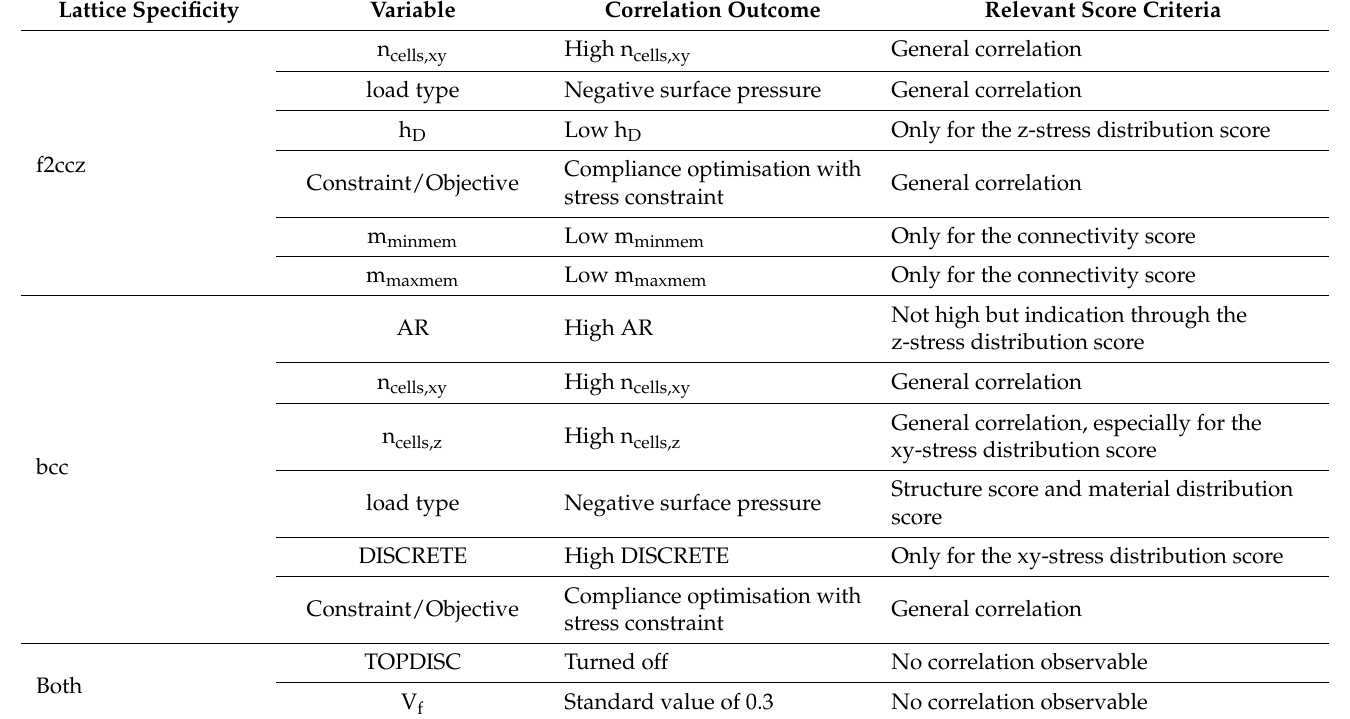
Table 2. Results—DoE correlation analysis—main correlations